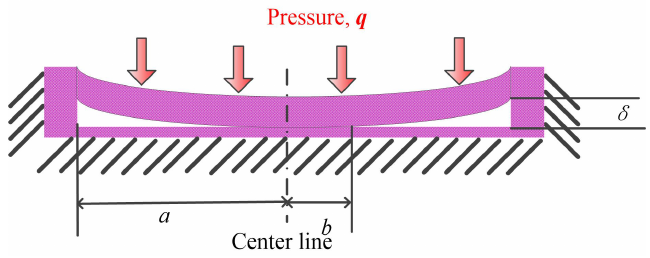
Figure 4. Deflection of circular plate with inner radius b (collapse